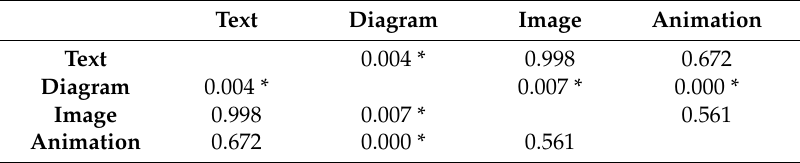
Figure 9. Comparison of SUS results (full score = 100). Table 10. Post-hoc test of usability: significance of the four interfaces.